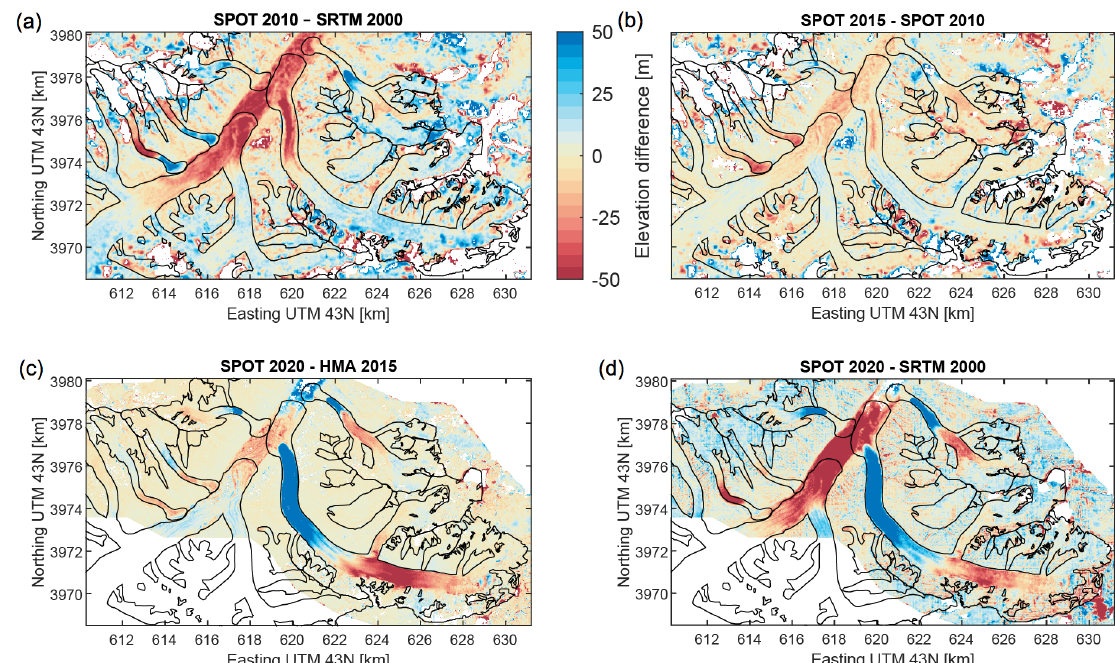
Figure 11. Two-dimensional elevation difference maps over the study region. (a) SPOT 2010 − SRTM 2000, (b) SPOT 2015 − SPOT 2010, (c) SPOT 2020 − HMA 2015, (d) SPOT 2020 − SRTM 2000. A comparison between the SPOT 2015 and the HMA DEM from 2015 is shown in Fig.